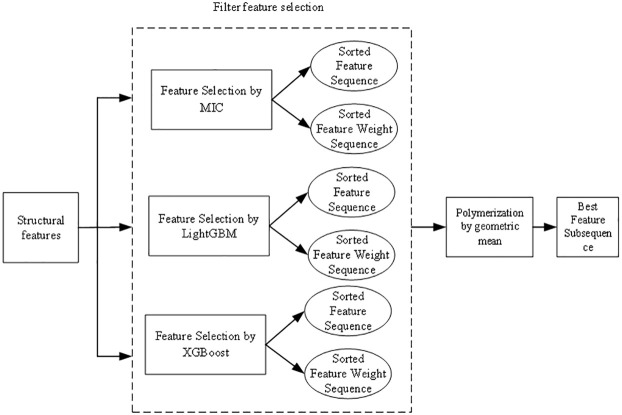
Framework of SA-EFS ensemble feature selection.